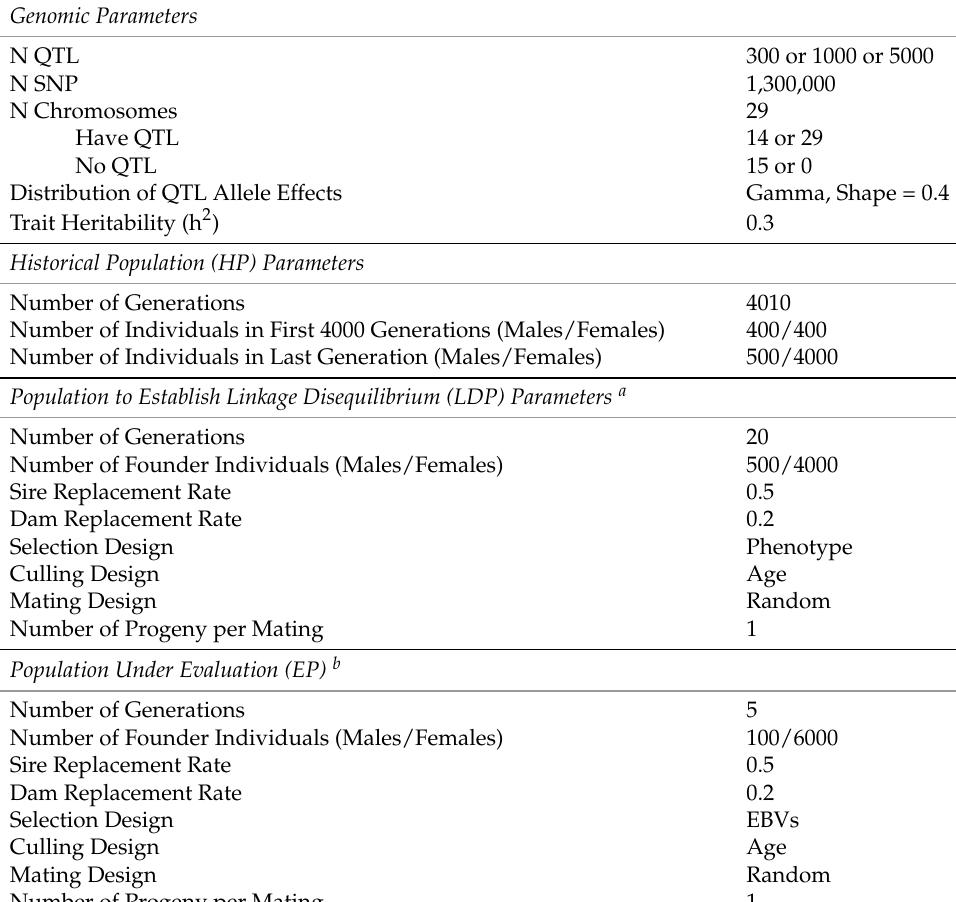
Table 2. Simulation parameters for